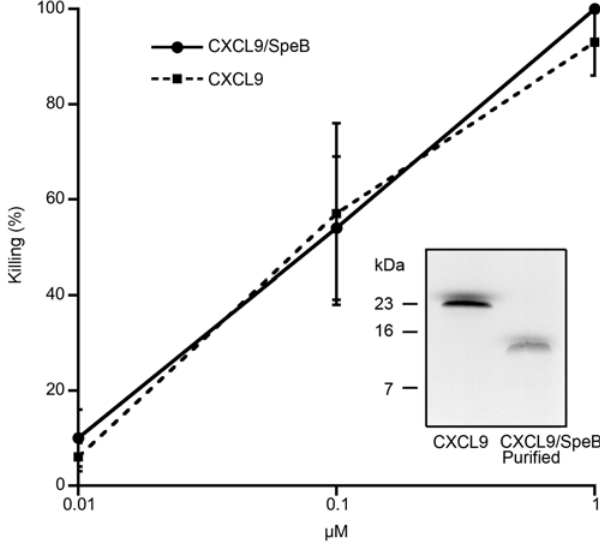
Figure 5. Dose dependent killing of S. pyogenes killing by CXCL9 and the SpeB generated fragment. The purified 18–73 SpeB generated CXCL9 fragment was compared to the intact CXCL9 for killing of S. pyogenes strain AP1. Curves represent mean bacterial killing in percent with standard error determined from at least three independent experiments. Inset: Intact CXCL9 and ion exchange chromatography purified SpeB generated CXCL9 fragment separated on 16.5%